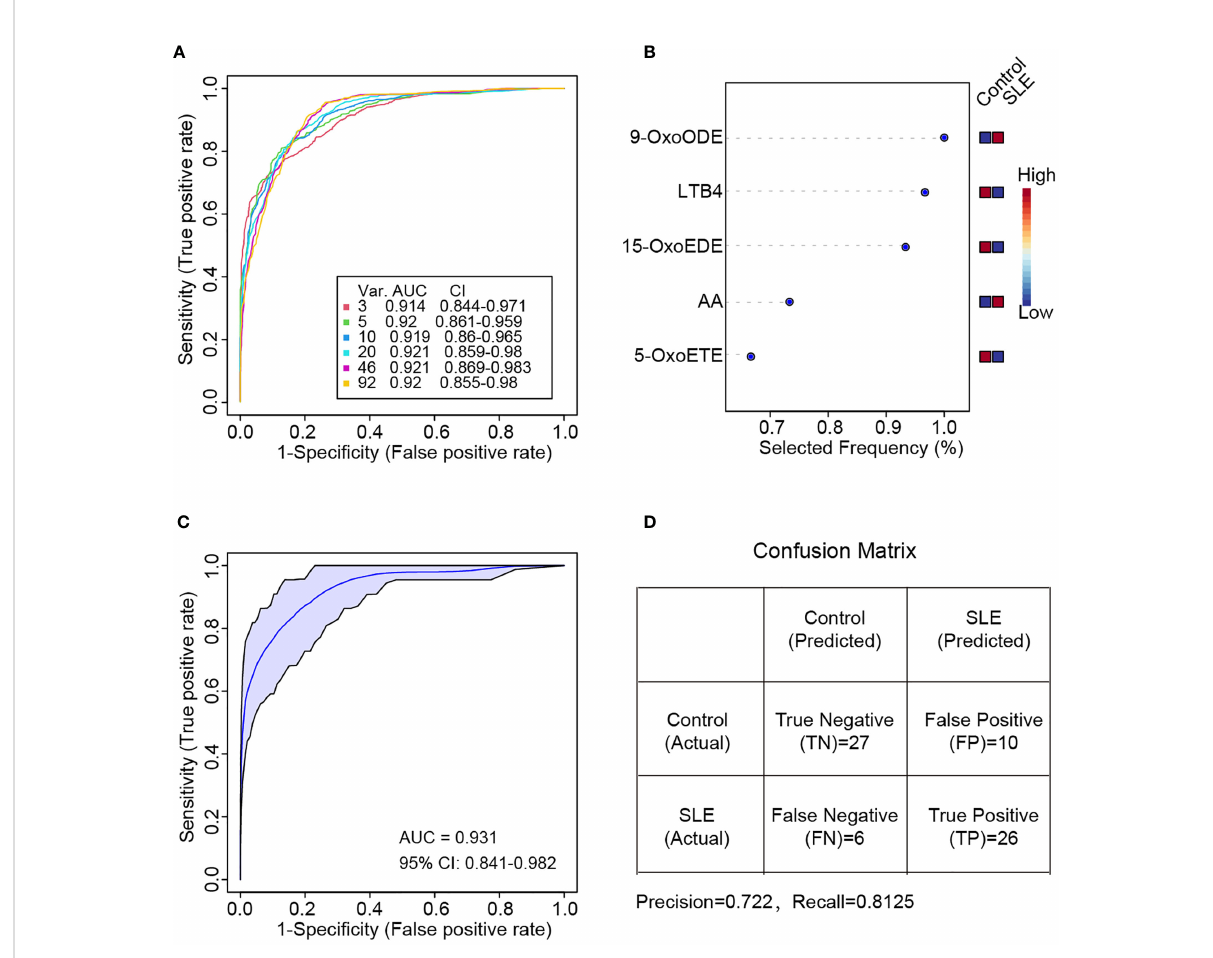
FIGURE 5 Random forest-based classi fi cation of SLE patients. (A) ROC curve of different oxylipin combinations for SLE classi fi cation. Six curves (3, 5, 10, 20, 46 and 92 features respectively) and the corresponding AUC and 95% con fi dence interval (CI) were shown. (B) Selected frequency of the top 5 most important features in random forest modeling. (C) ROC curve based on the fi ve most important features in (B) Two thirds of samples were used for random forest modeling by directly using the fi ve most important features in (B, D) Confusion matrix for the prediction of the one third hold out samples. The precision and recall value also